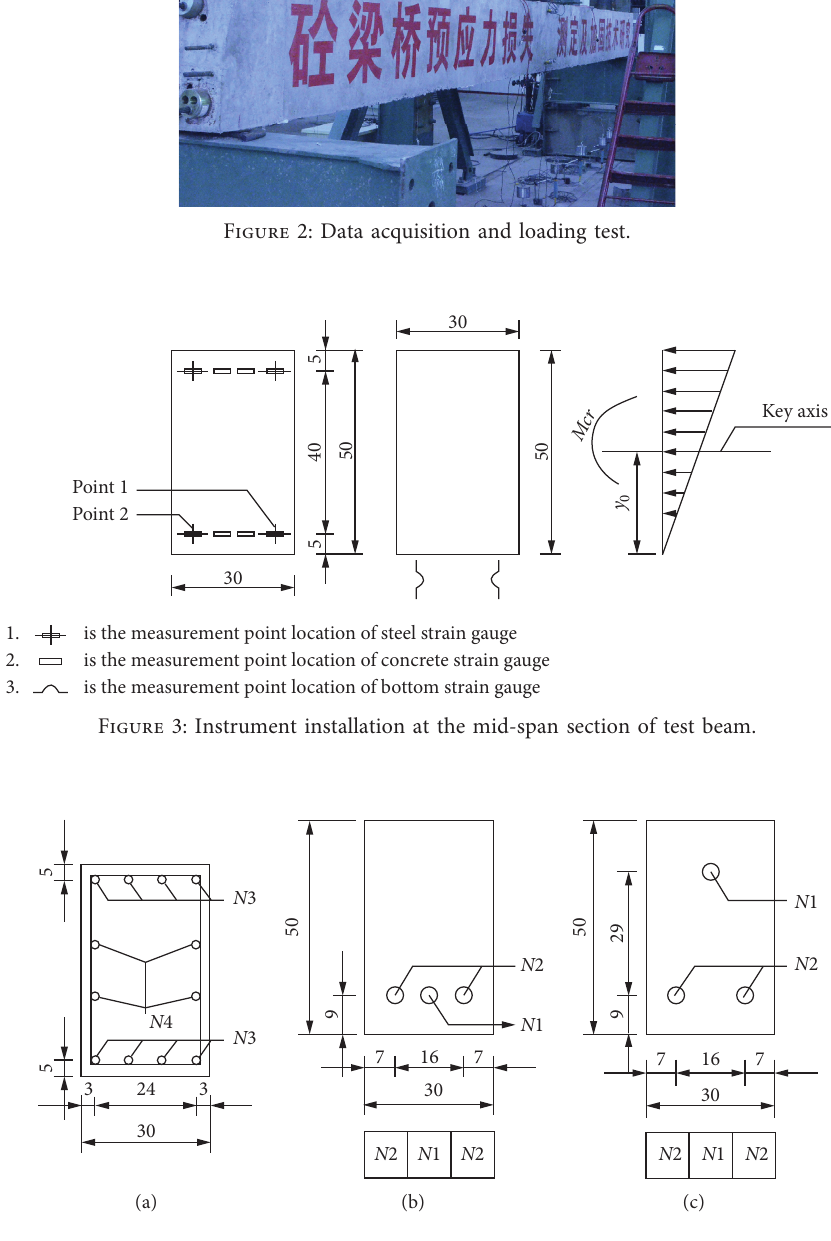
Figure 4: Position of steel bars and strands. (a) Steel bars. (b) Strand ( L /2). (c) Strand (anchor